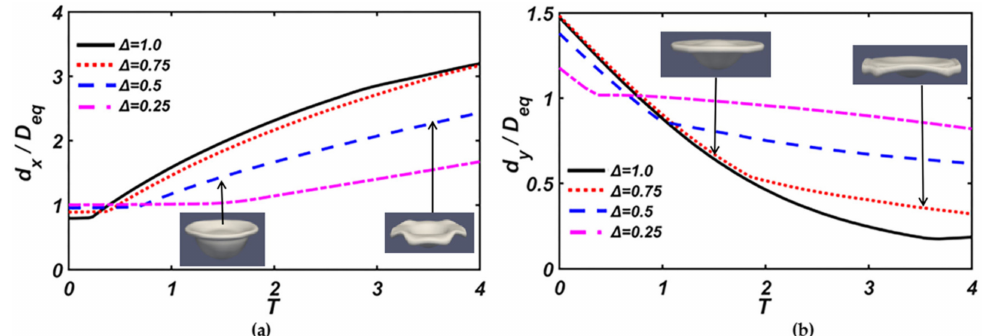
Figure 5. Evolution of the maximum diameter of the droplets with di ff erent size ratios: ( a ) the dimensionless maximum radial diameter of the droplet ( d x / D eq ), and ( b ) the dimensionless maximum axial diameter of the droplet ( d y / D eq